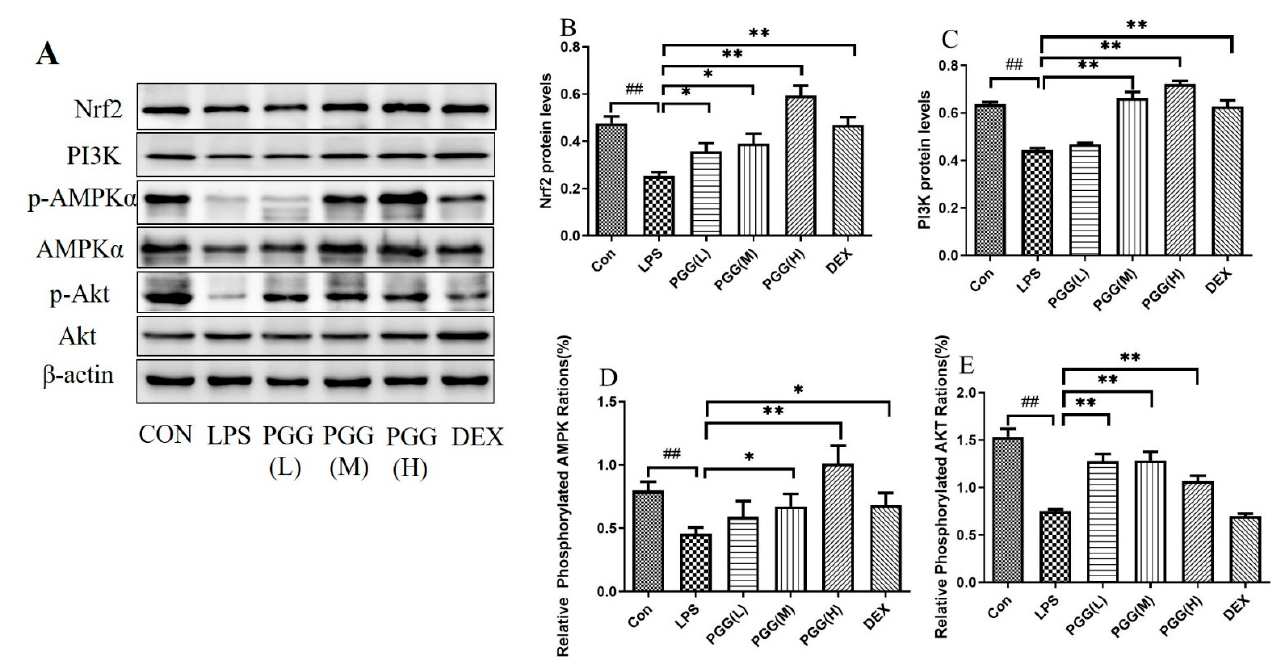
Figure 3. Effect of PGG on expression levels of p-AMPK/AMPK, PI3K, p-Akt/Akt and Nrf2 in lung tissues of ALI rats. ( A ) The protein levels of p-AMPK/AMPK, PI3K, p-Akt/Akt and Nrf2 in lung tissues were determined by Western blotting; ( B ) The expression of Nrf2 in lung tissues; ( C ) The expression of PI3K in lung tissues; ( D ) The expression of p-AMPK/AMPK in lung tissues; ( E ) The expression of p-Akt/Akt in lung tissues. Representative Western blot images of four proteins are altered in the LPS-challenged PGG- and DEX-treated groups compared with the LPS group. Statistical analysis of the protein expressions of p-AMPK/AMPK, PI3K, p-Akt/Akt and Nrf2 was performed. β -actin was used as the reference. Values are expressed as the mean ± standard deviation (SD) ( n = 3). ## p < 0.01 vs. Con group; * p < 0.05, ** p < 0.01 vs. LPS group. P-Akt, protein kinase B phosphorylation; AKT, protein kinase B; ALI, acute lung injury; p-AMPK, adenosine monophosphate-activated protein kinase phosphorylation; AMPK, adenosine monophosphate-activated protein kinase; Con, control group; DEX, dexamethasone; LPS, lipopolysaccharide; Nrf2, nuclear factor erythroid 2-related factor; PGG, 1,2,3,4,6-O-pentagalloylglucose; PGG (LD), PGG (15 mg/kg) + LPS group; PGG (MD), PGG (30 mg/kg) + LPS group; PGG (HD), PGG (60 mg/kg) + LPS group; PI3K, phosphoinositide 3-kinase.